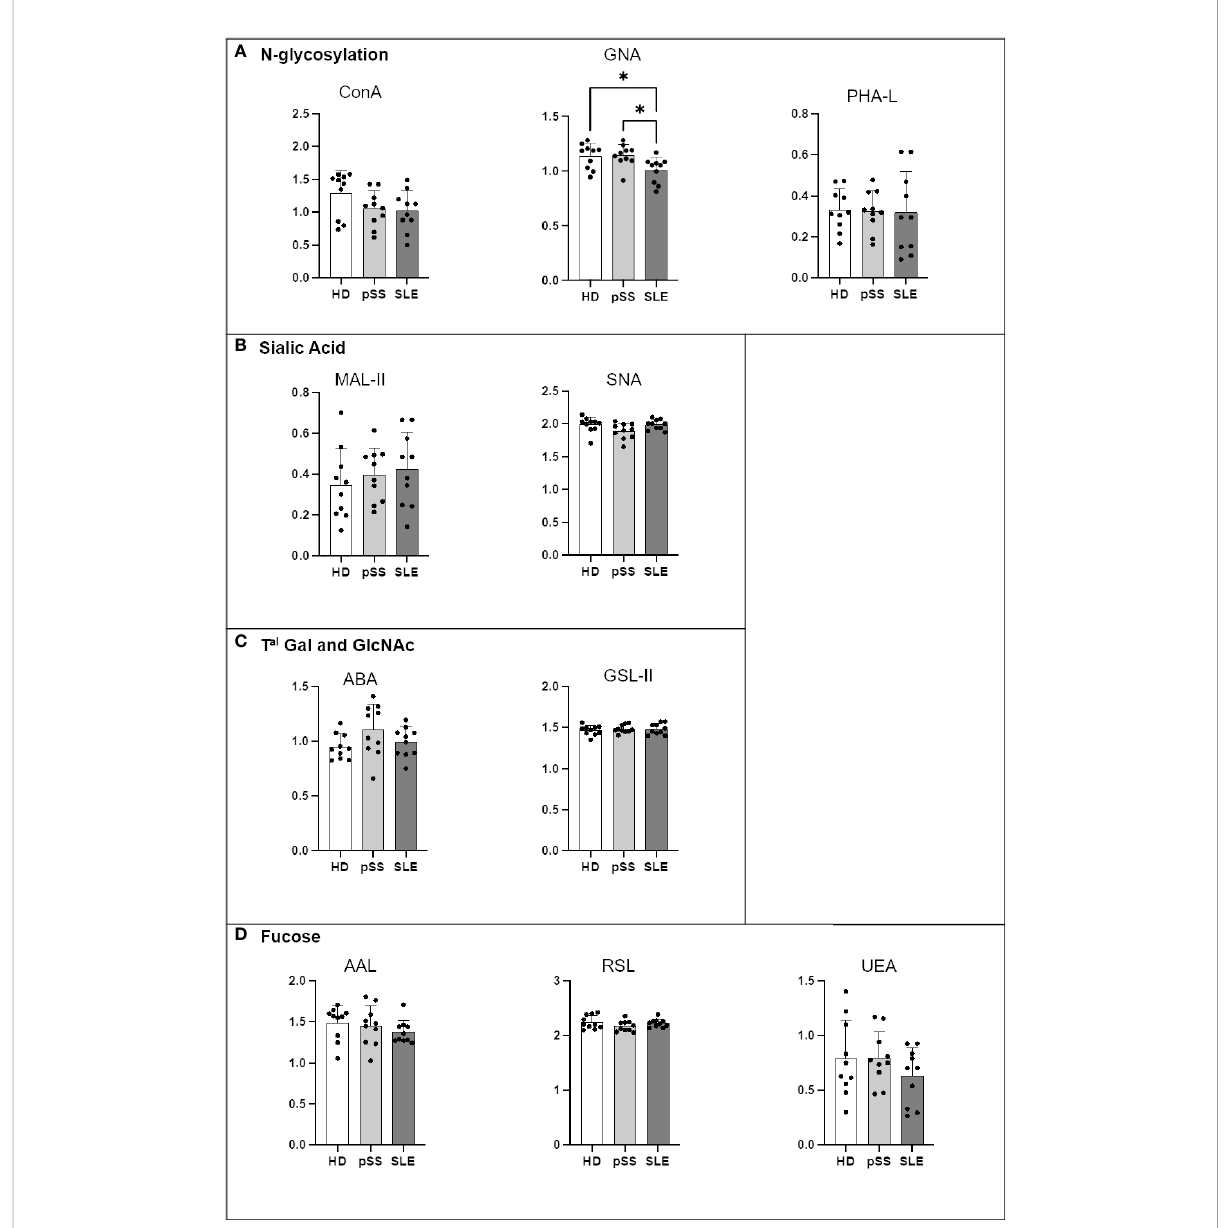
FIGURE 8 Comparison of IgA2 N-glycosylation from systemic lupus erythematosus (SLE), primary Sjögren ’ s syndrome (pSS) and healthy donors (HD). Mouse anti-Human IgA2 (RM125 clone) was coated at 0.5 µg/mL in MaxiSorp 96-well plates overnight at 4°C. A PBS solution containing 2% of BSA or Carbohydrate-Free Blocking Solution were used for saturation depending on the lectins. This information is described in Table 4. After saturation, an oxidation was performed, to cleave terminal glycans present on anti-Ig and saturating buffer, with a solution of sodium periodate at the fi nal concentration of 0,05 M in 0,05 M pH=4 citrate buffer. Serum from healthy donors (HD), pSS and SLE diluted to 1/100e were added for 1 h at 37°C. After 5 wash steps with PBS 0,05% Tween20, the biotinylated lectins described in Table 2 were added for 1 h. Plate was washed 5 times and streptavidin-HRP was added for 30 min at RT. After 5 wash steps, a colored reaction using tetramethylbenzidine was performed and stopped with sulfuric acid. The optical density (OD) at 450 nm was determined. Results are presented as followed: N-glycosylation in (A) , Sialylation in (B) , Terminal (Tal) Gal and GlcNAc on N and O-glycosylation in (C) , and Fucosylation in (D) . One-way anova test followed by Dunn ’ s multiple comparison test were performed. ns: not signi fi cant p > 0,05, stars are indicated when p< 0,05